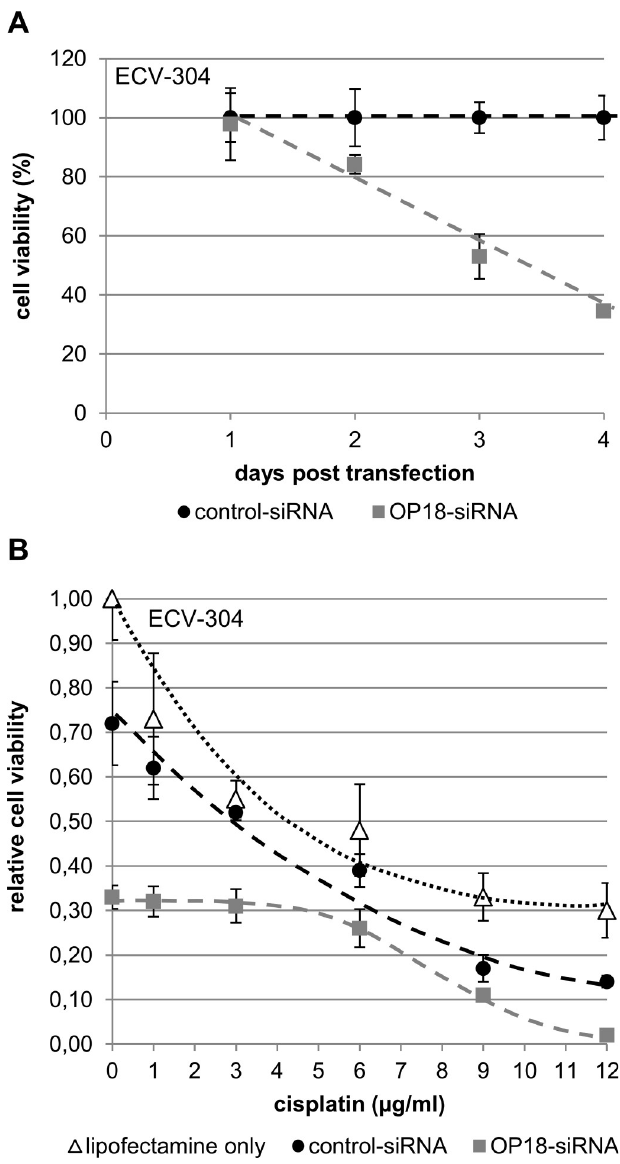
Fig 5. Chemo-sensitivity of BCa cells after suppression of OP18. ECV-304 cells were transfected in triplicate with each 30 nM of OP18- and control siRNA. (A), cell viability of siRNA-treated ECV-304 cells. The viability of ECV-304 cells was quantified with the colorimetric MTS-assay at 1, 2, 3, 4 days after transfection in triplicate (30 nM OP18- and control-siRNA). Symbols indicate mean values ± standard deviation of three independent experiments. Cell viability of OP18-siRNA treated ECV-304 was significantly decreased at days 2, 3, and 4 post transfection compared to control cells. (B) Cells were treated for 24 h with increasing concentrations of cisplatin (0, 1, 3, 6, 9, and 12 µ g/ml) 48 h after transfection followed by quantification of cell viability. Data indicate mean values ± standard deviation and are representative of three independent experiments. ECV-304 cells treated with OP18-directed siRNA show a significant reduction of cell viability in the presence of cisplatin , particularly at highest cisplatin concentrations (12 µ g/ml). OP18-suppressed ECV-304 cells was in the order of one magnitude while in the absence of cis- platin, this was only approximately twofold (Fig 5A, and 5B, “0” µ g/ml cisplatin). At low con- centrations of cisplatin (1, 3 and 6 µ g/ml), the effect on relative cell viability was similar in OP18-suppressed cells and controls.